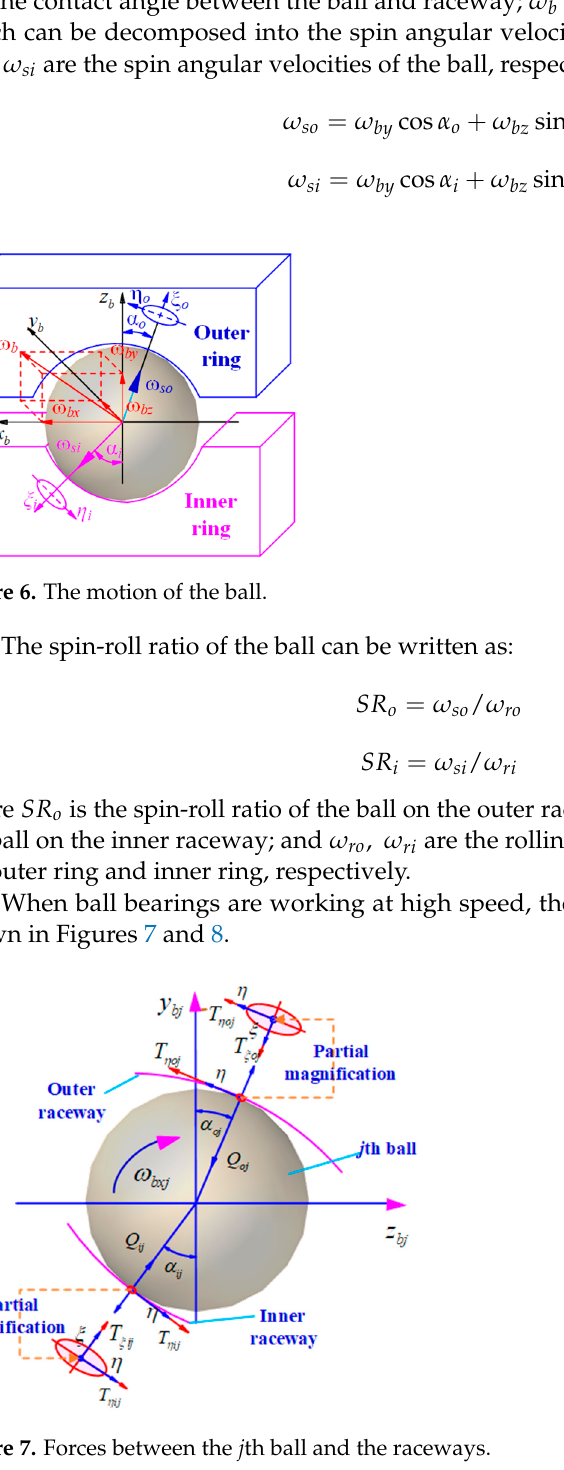
Q is the collision force between the j th ball cj d is the inner diameter of the cage; c